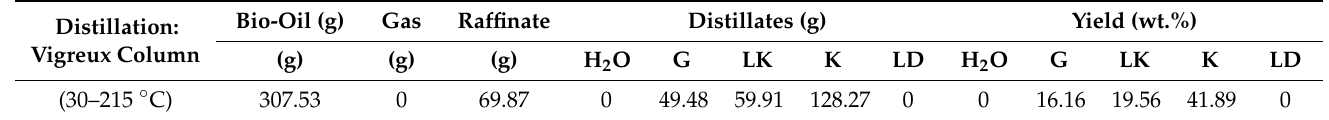
Table 5. Material balance and yields by fractional distillation of bio-oil.